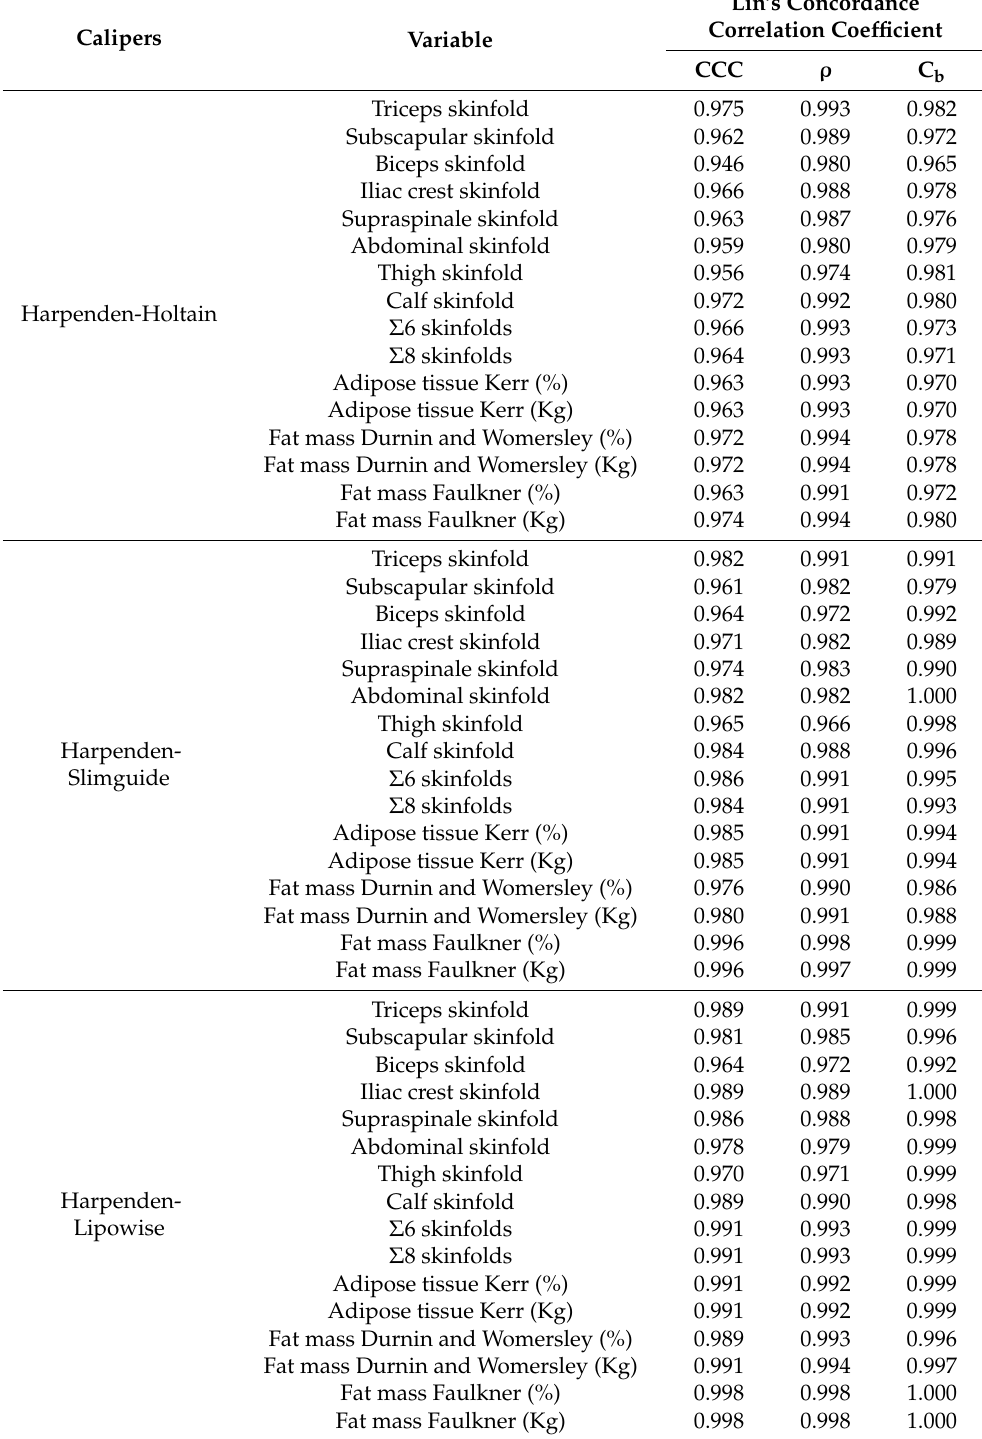
Table 4. Lin’s concordance correlation coefficient between the different calipers in the analyzed